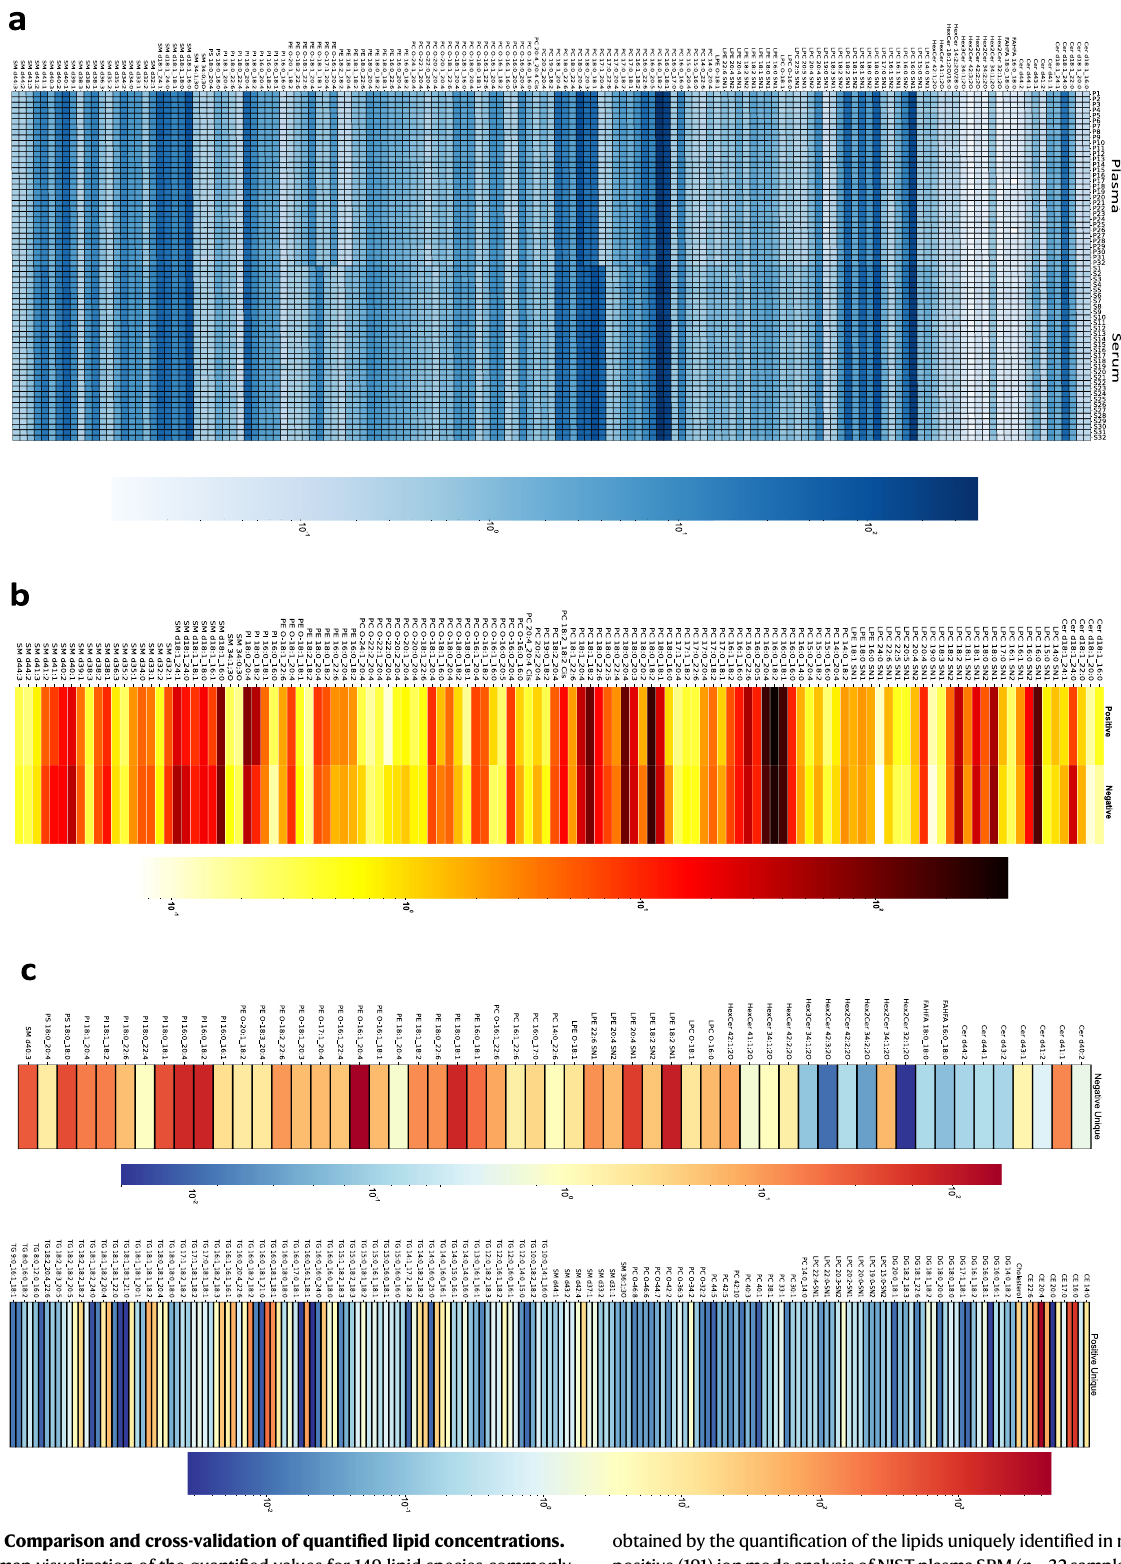
obtainedby the quanti fi cation of the lipids uniquely identi fi edin negative (55)and positive(191)ionmodeanalysisofNISTplasmaSRM( n =32samplesineachmode). For each heatmap, log 10 of the quanti fi ed values (nmol/mL) was used for the visualization. Source data are provided as a Source data fi le and in Supplemen- tary Data